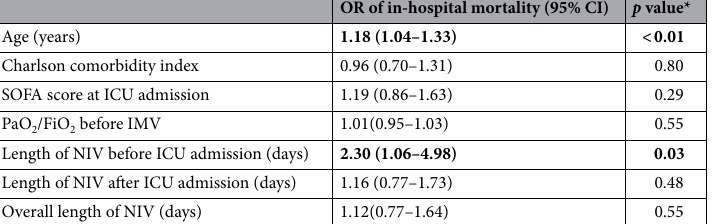
OR of in-hospital mortality (95% CI) p